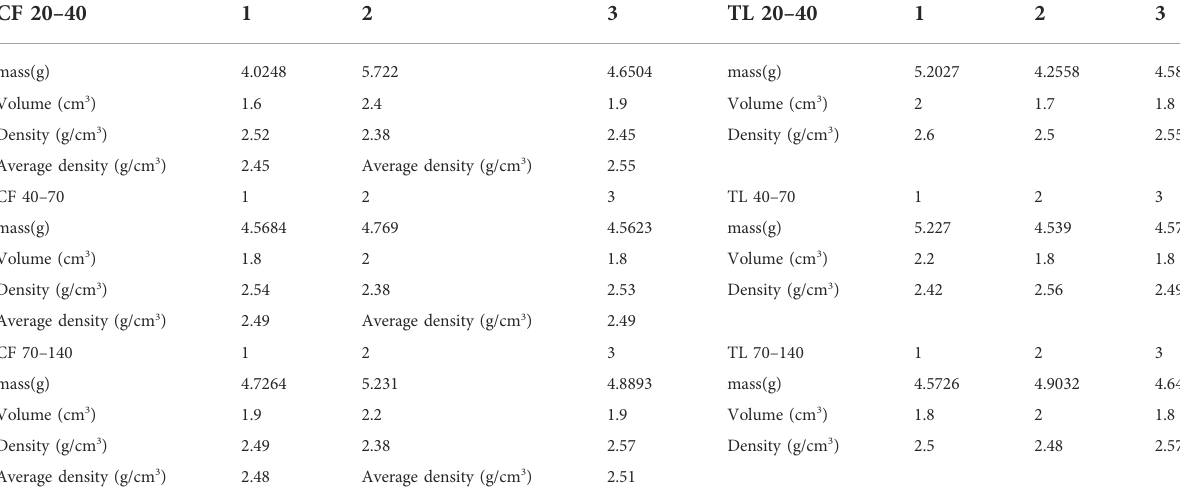
TABLE 1 The critical thickness of the interface region in different fl uid-nanopore